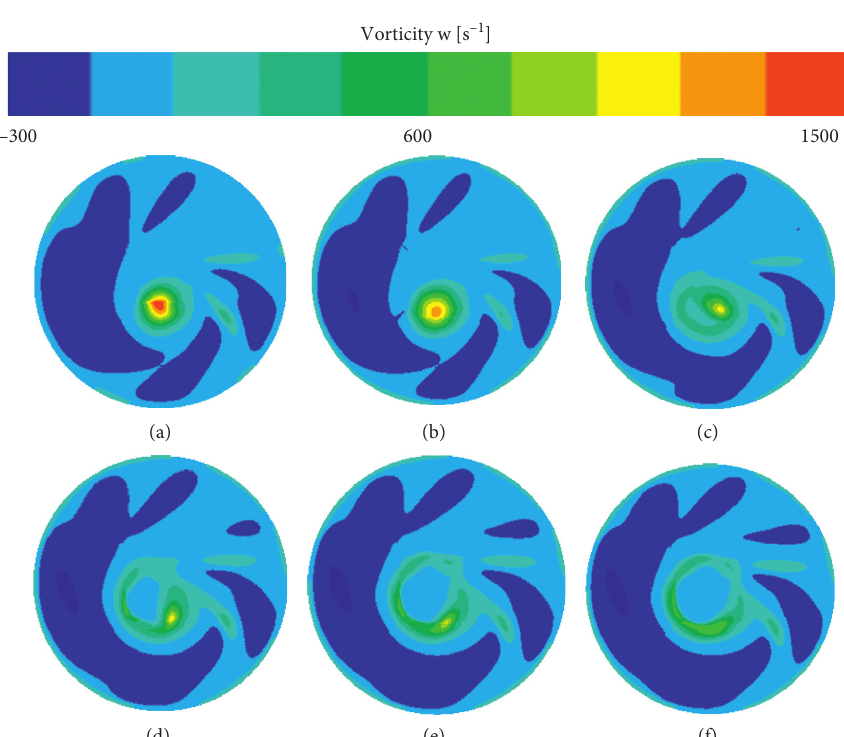
Figure 13: Cloud diagram of vorticity distribution in the section of the outlet of the nozzle. (a) Original device, (b) v � 8, (e) v � 12, (f) v � (d) v jet jet jet